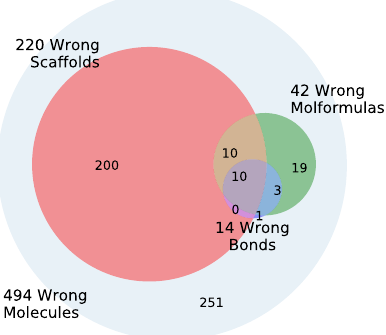
Figure 8. Venn diagram of the errors encounted during molecule reconstruction of 1000 molecules for the GDB-8 can2enum model.